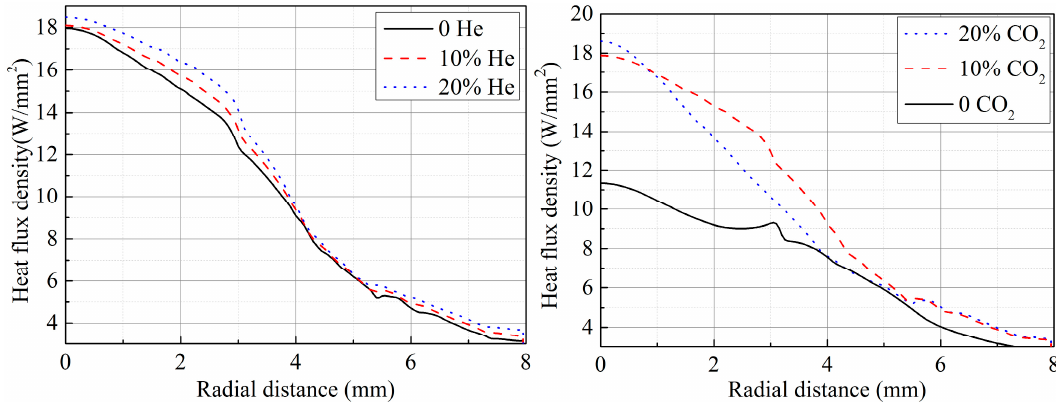
Figure 7. Heat flux density distribution for different helium or CO 2 contents.